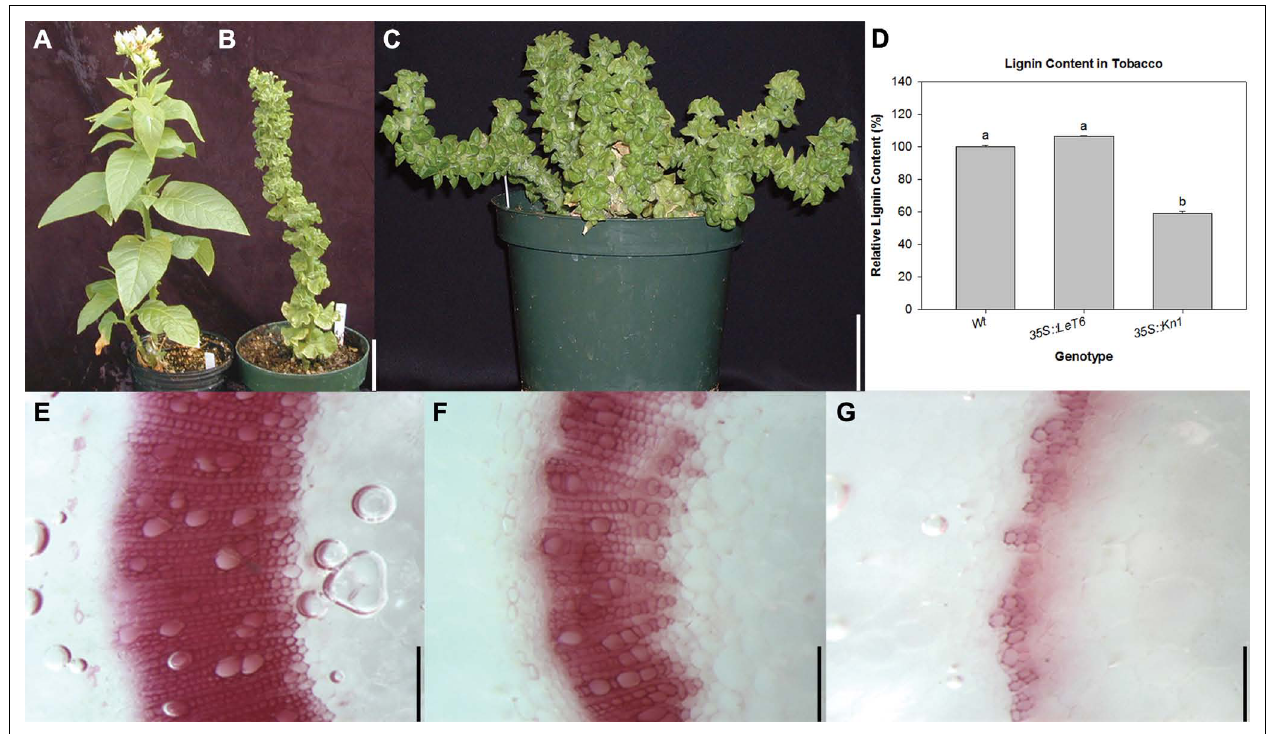
FIGURE 2 | Comparison of (A) wild-type (Wt), (B) 35S:LeT6 , and (C) 35S:Kn1 tobacco plants. (D) Relative lignin content inWt and transgenic 35S::LeT6 and 35S::Kn1 tobacco plants. Error bars represent standard error